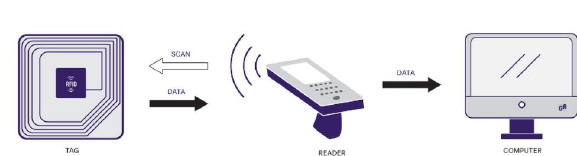
Figure 4: Reading phase of an RFID tag with an internet connected reader RFID technology can be grouped into three frequency ranges as reported in Table 2